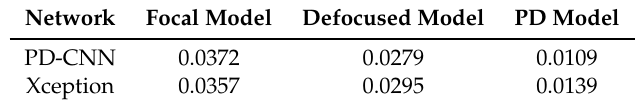
Table 2. The Loss (MSE) of test data set in PD-CNN and Xception.